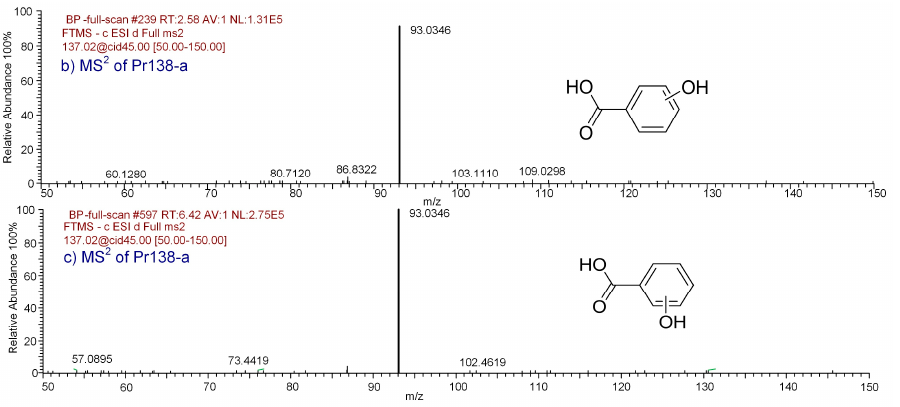
Figure A4. MS 2 spectra of Pr138-a and Pr38-b by HRMS.